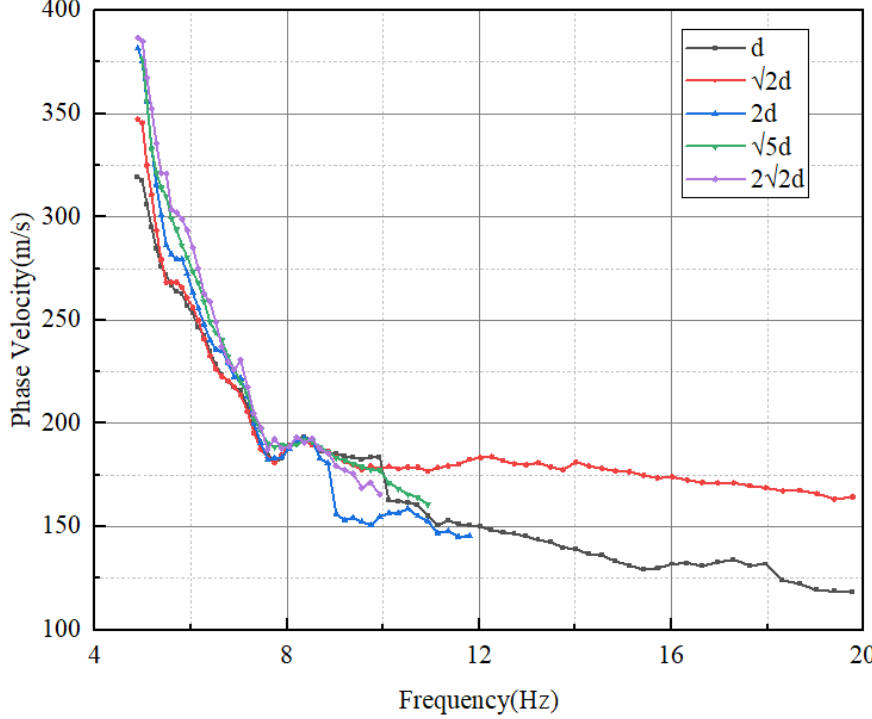
Figure 11. Average dispersion curves of five-station distance combinations.